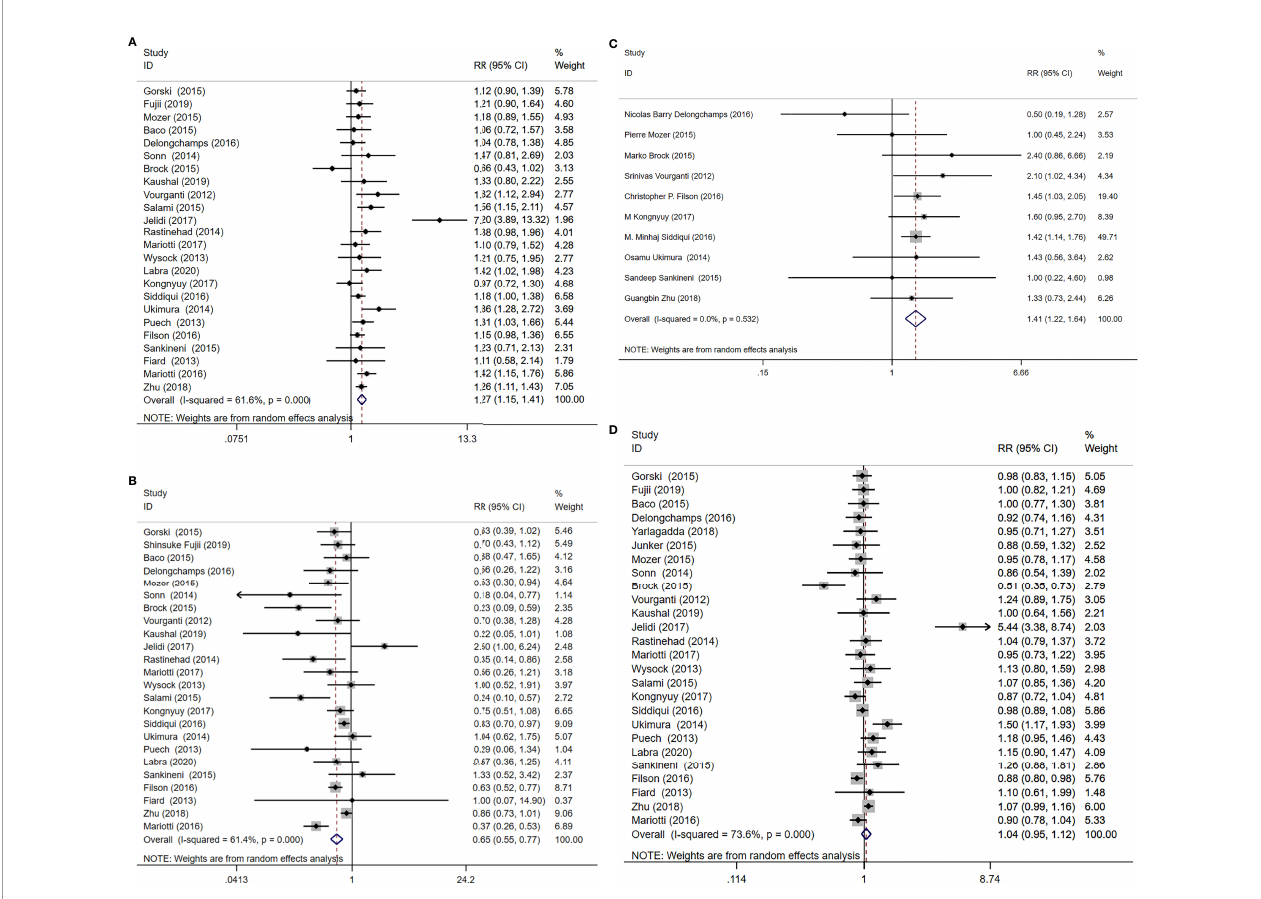
FIGURE 3 | MRI/Transrectal Ultrasound (TRUS) fusion guided-targeted biopsy (MRI-TB) versus transrectal ultrasound-guided biopsy (SB) for the detection of (A) clinically signi fi cant prostate cancer, (B) clinically insigni fi cant prostate cancer, (C) high-risk prostate cancer, (D) overall prostate